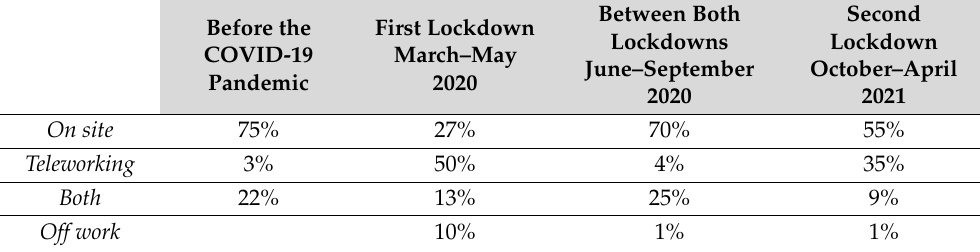
Table 2. Prevalence rate for social professionals’ characteristics of the psychologists’ sample (N = 187) and their working environments.